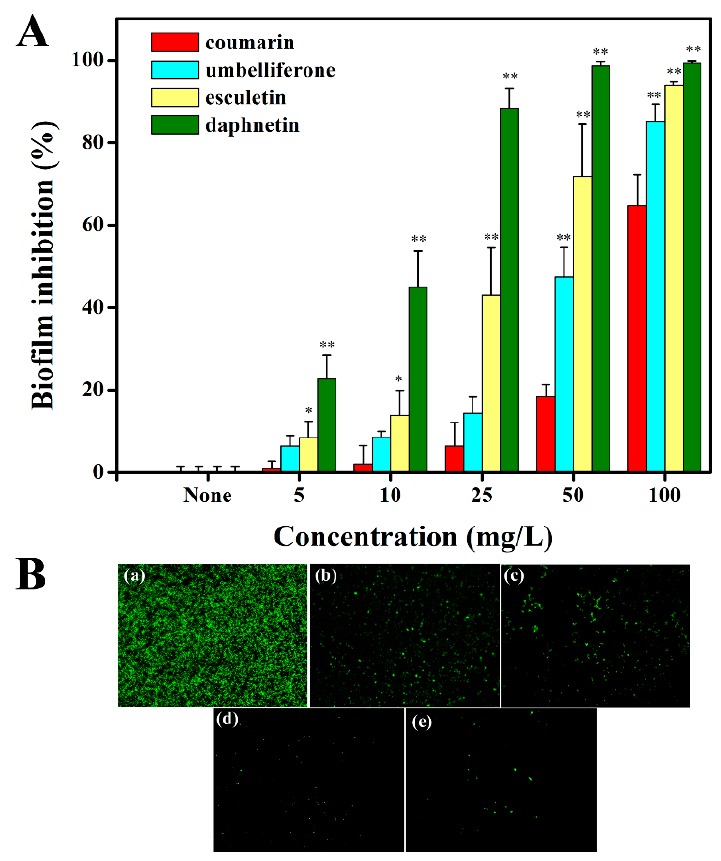
Figure 4. Effects of coumarins on biofilm formation of R. solanacearum . Biofilm inhibition (%) was quantified after treatment with different concentrations of coumarins at 30 °C for 24 h in the 96-well plates ( A ); (* indicated p < 0.05, ** indicated p < 0.01). Fluorescence microscope imaging of biofilm formation of R. solanacearum using FITC-ConA tagged with extracellular polysaccharide in 24-well polystyrene microtiter plate ( B ); Fluorescence microscope imaging of R. solanacearum with ( a ) 50 mg/L DMSO (control treatment); ( b ) coumarin (50 mg/L); ( c ) umbelliferone (50 mg/L); ( d ) esculetin (50 mg/L); ( e ) daphnetin (50 mg/L).